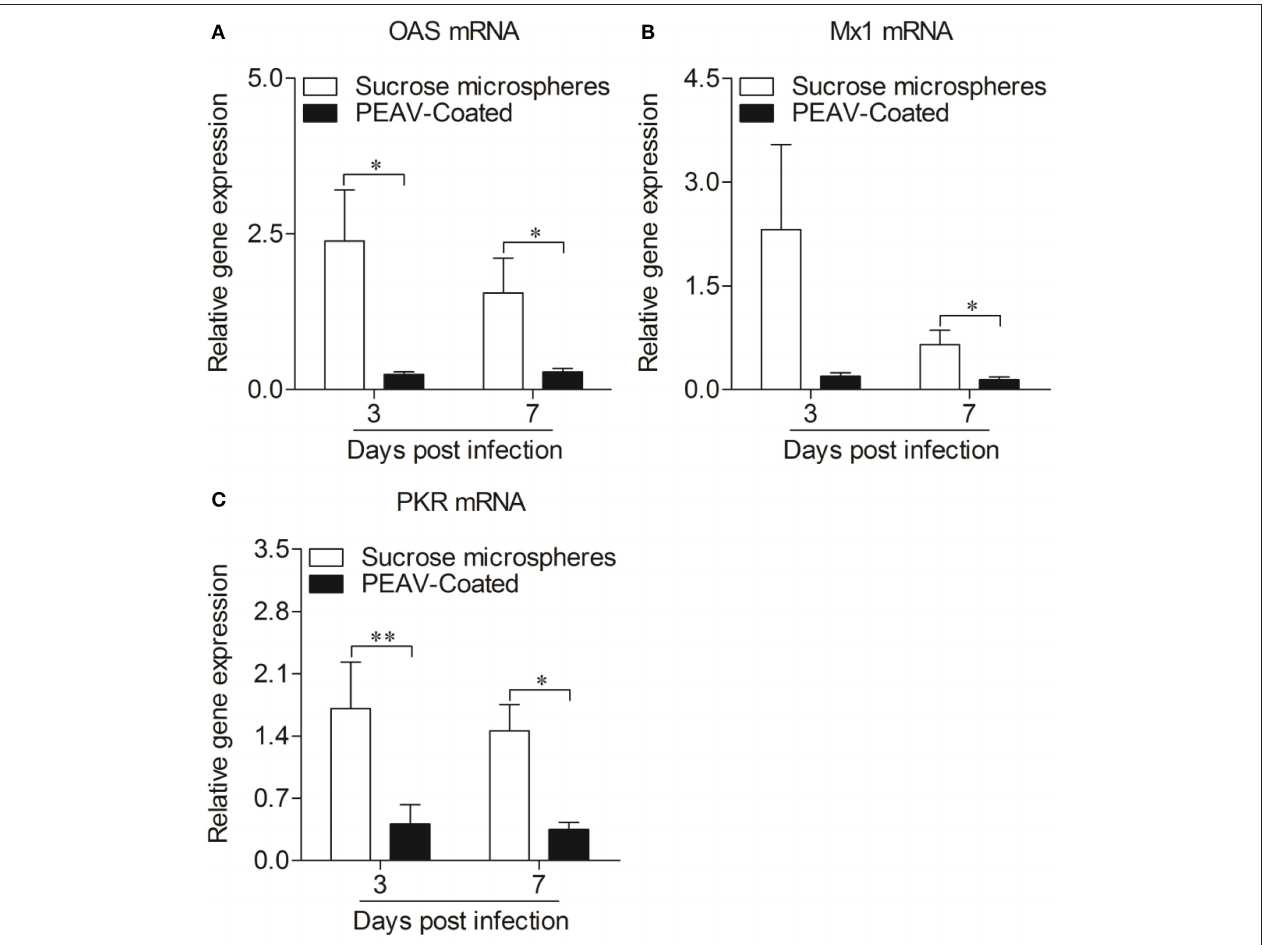
FIGURE 6 | Expressions of antiviral molecules mRNA in Peyer’s patches from weaned piglets after infection with PEAV-Coated at 3 d.p.i. and 7 d.p.i. The mRNA expressions of OAS (A) , Mx1 (B) , and PKR (C) in Peyer’s patches from weaned piglets after infection with PEAV-Coated were examined with real-time PCR using specific primers at 3 d.p.i. and 7 d.p.i. The mRNA expression levels of these molecules were calculated relative to the expression level of GAPDH . Data are represented as mean ± SD, n = 6. ** p < 0.01, * p <